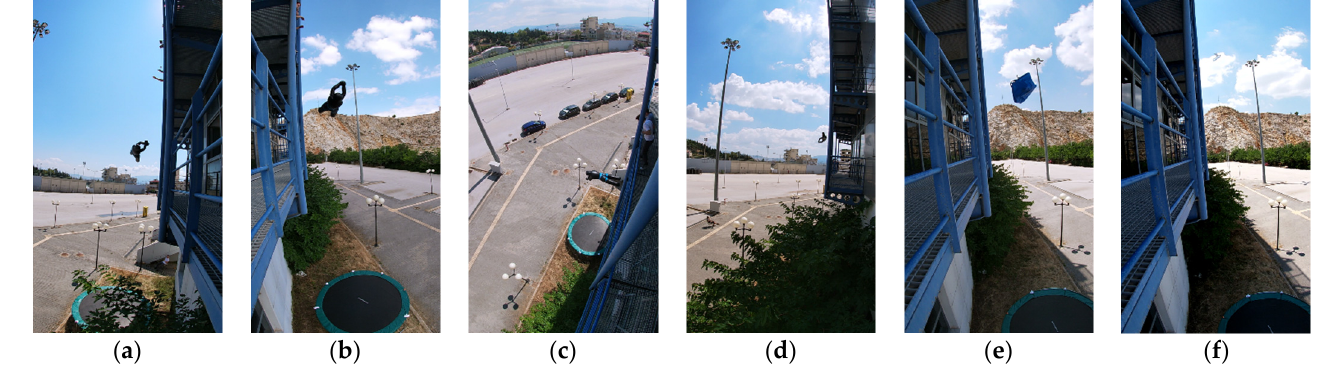
Figure 4. Test throws of the dummy during the data collection experiments (as presented in [15]). The freefall ( a – d ) of the human dummy from different shooting angles (positive events) and various other objects, such as ( e ) plastic bags and ( f ) bottles (negative events).